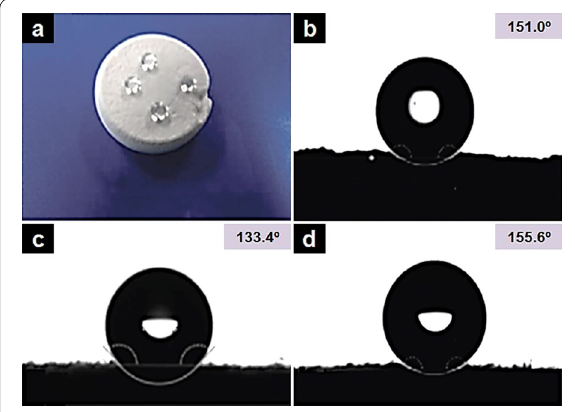
Fig. 7 Images of water droplets on bulk SiO 2 aerogel and cotton fabrics: a Digital image of water droplets on bulk SiO 2 aerogel; b water contact angle of bulk SiO 2 aerogel; c water contact angle of cotton fabric sample coated by PDMS alone and d water contact angle of cotton fabric sample coated by PDMS/SiO 2 aerogel [71] Copyright 2014 Chemical and Materials